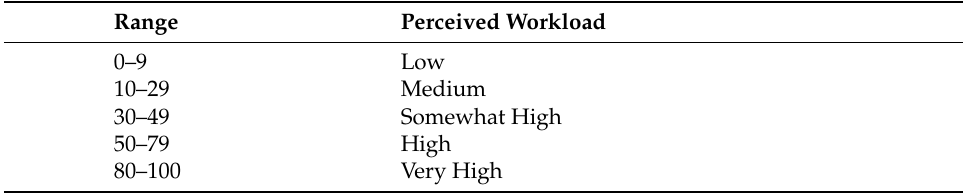
Table 2. Interpretation of the Raw TLX